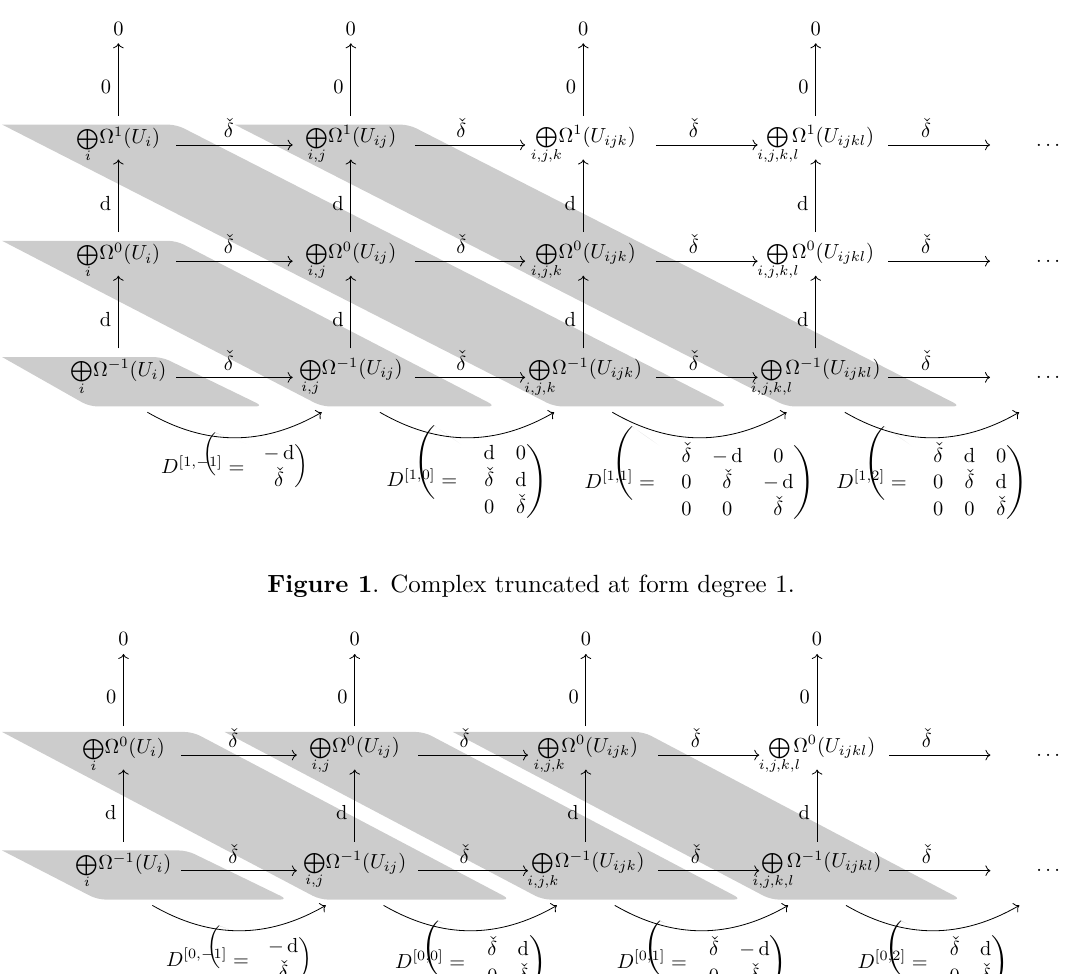
Figure 2 . Complex truncated at form degree 0